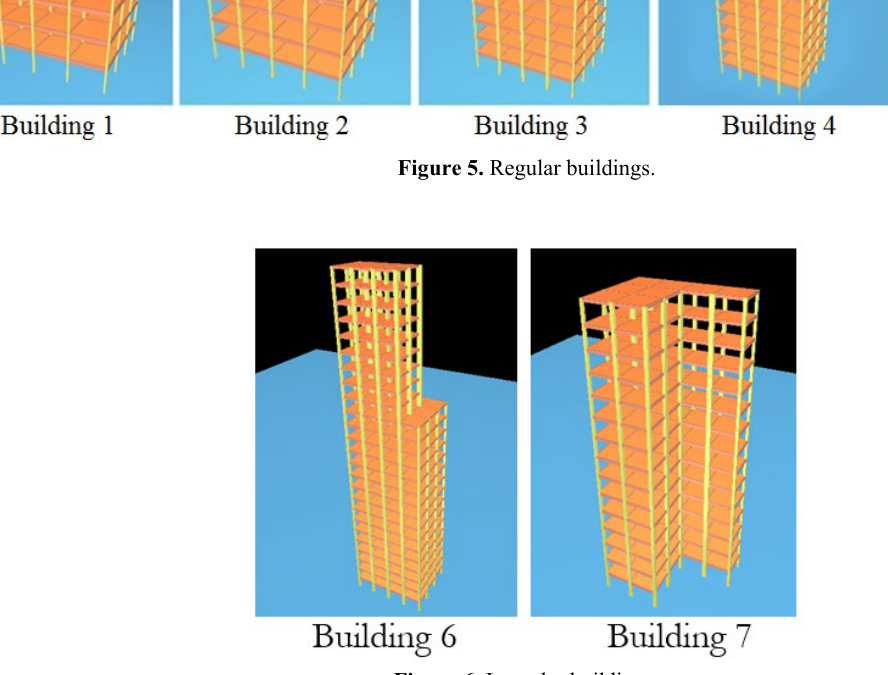
Figure 6. Irregular